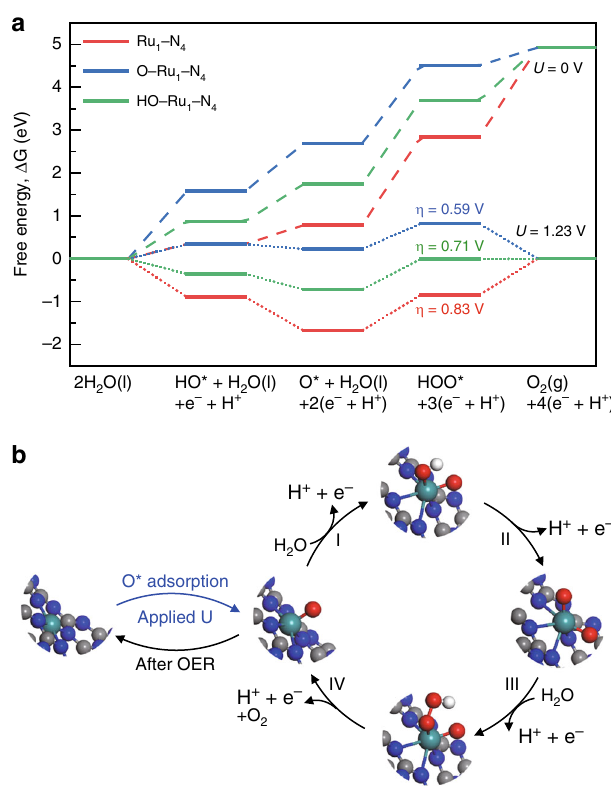
Fig. 4 Density functional theory calculation for the OER mechanism. a Free energy diagram for OER on Ru 1 -N 4 (red line), O-Ru 1 -N 4 (blue line), and HO- Ru 1 -N 4 (green line). b Schematic of the whole OER mechanism on Ru-N-C catalyst in the acidic electrolyte. The balls in gray, blue, red, white, and light green represent C, N, O, H, and Ru atoms, respectively. All potentials